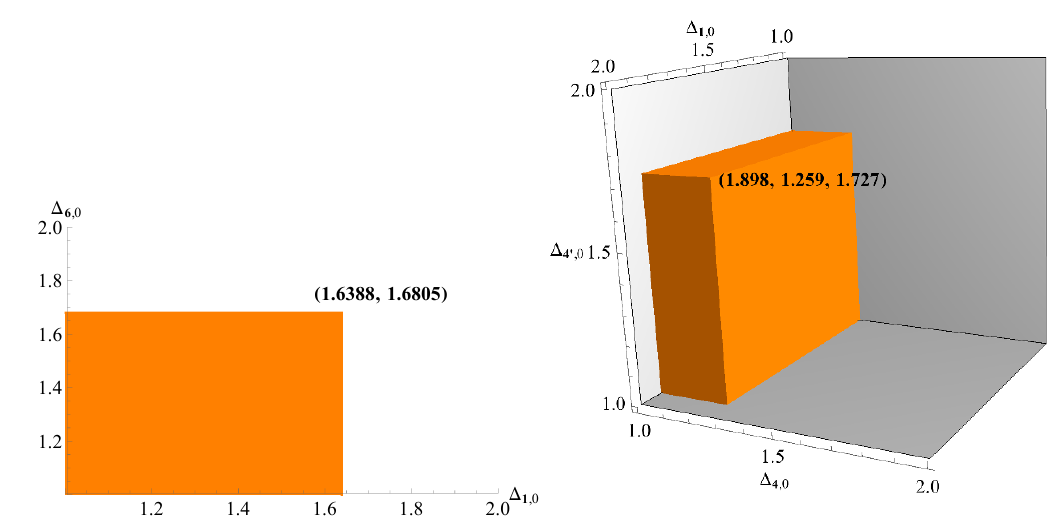
Figure 4 . Left: bounds on the unprotected scaling dimensions (cid:1) 6 ; 0 and (cid:1) 1 ; 0 for the XYZ model in d = 3, computed using G o S 3 (cid:13)avor symmetry crossing equations. Right: bounds on the unprotected scaling dimensions (cid:1) 1 ; 0 , (cid:1) 4 ; 0 , and (cid:1) 4 0 ; 0 for the Z 2 (cid:2) Z 2 model in d = 3, computed using G o ( Z 2 (cid:2) Z 2 ) (cid:13)avor symmetry crossing equations. In terms of the two-dimensional irreps of G , we have (cid:1) 6 ; 0 = (cid:1) 2 0 ; 0 = (cid:1) 2 00 ; 0 = (cid:1) 2 00 ; 0 , (cid:1) 4 ; 0 = (cid:1) 2 ; 0 = (cid:1) 2 0 ; 0 , and (cid:1) 4 0 ; 0 = (cid:1) 2 00 ; 0 = (cid:1) 2 000 ; 0 . In both plots the orange denotes the allowed region, and we conjecture that the theory lives at the corner. These bounds were computed with (cid:3) = 27.